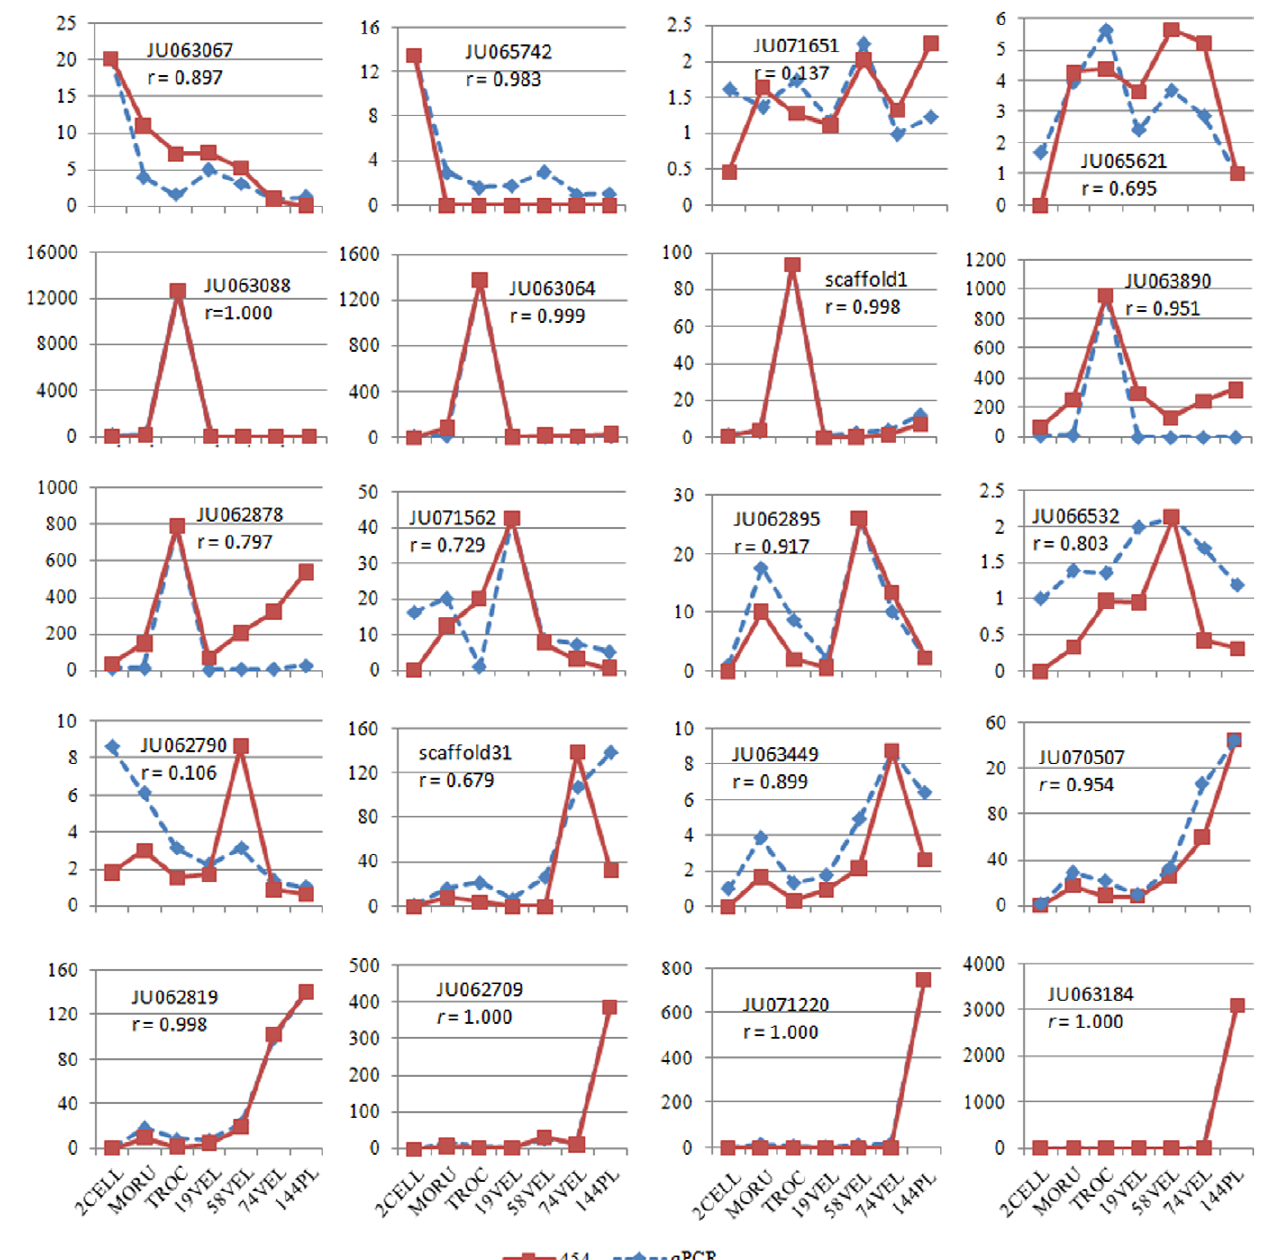
Figure 5. Validation of 20 temporal dynamics by qPCR. For the qPCR data, the lowest expression level of each gene was set as 1, and the other expression levels are indicated as the fold-change relative to it. The 454 expression levels of each gene were normalized to the 454 data for OAZ1 / YB1 and rescaled to the qPCR scales. Abbreviation: r , Pearson’s correlation coefficient.